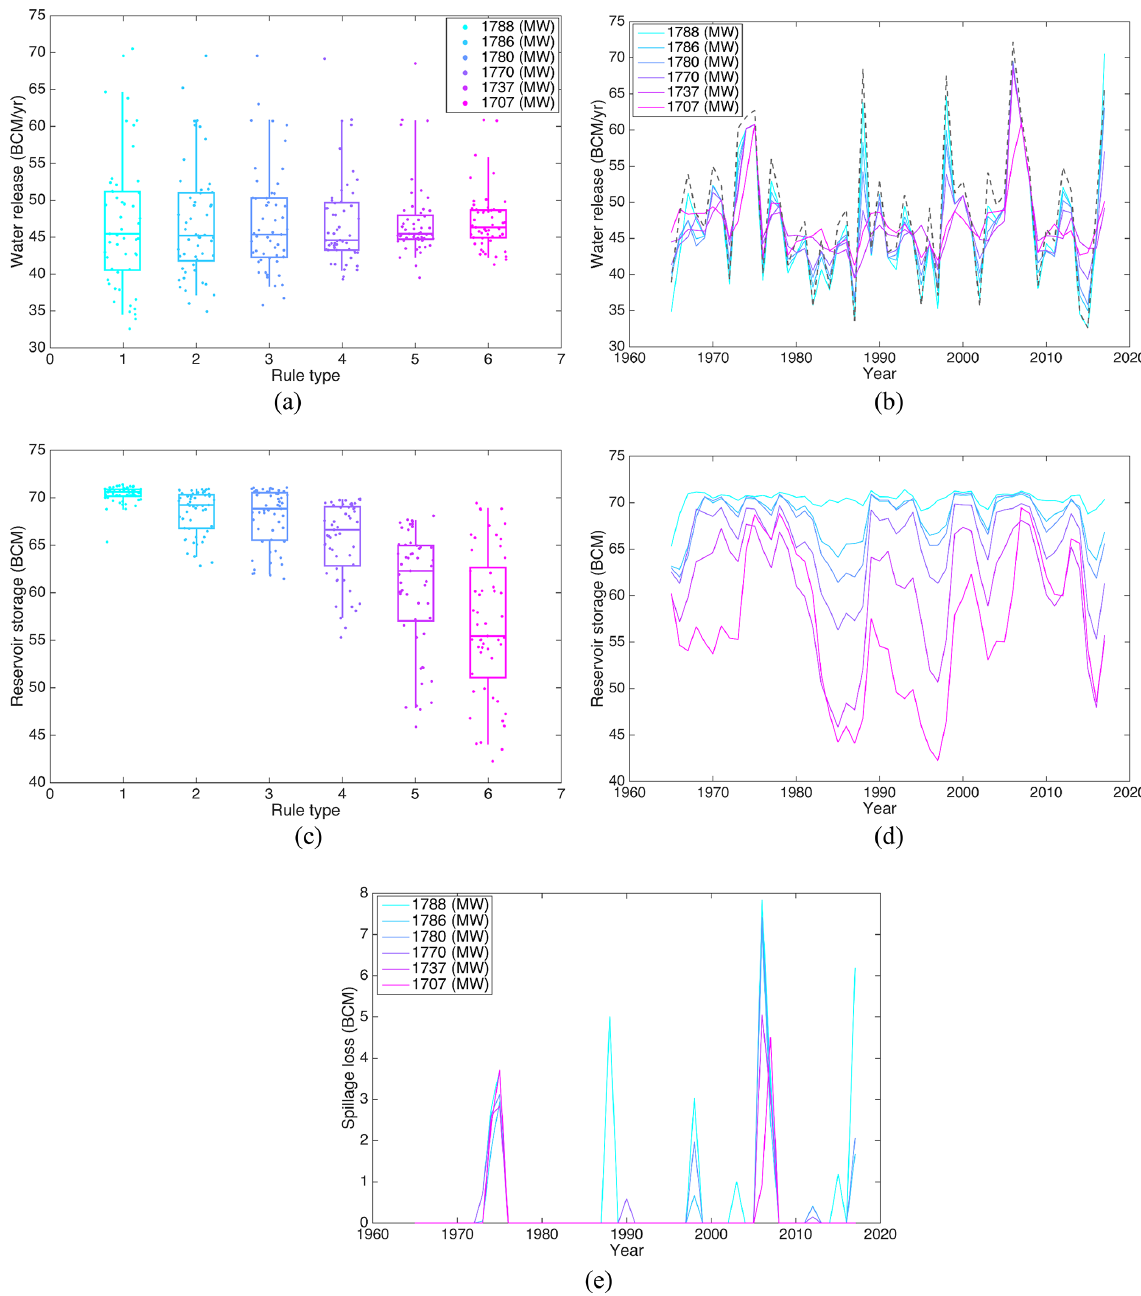
Figure 6. Box plots and values of annual reservoir (a, b) water releases, (c, d) storages, and (e) spillage for various reservoir operating rules. The dashed line in (b) refers to reservoir